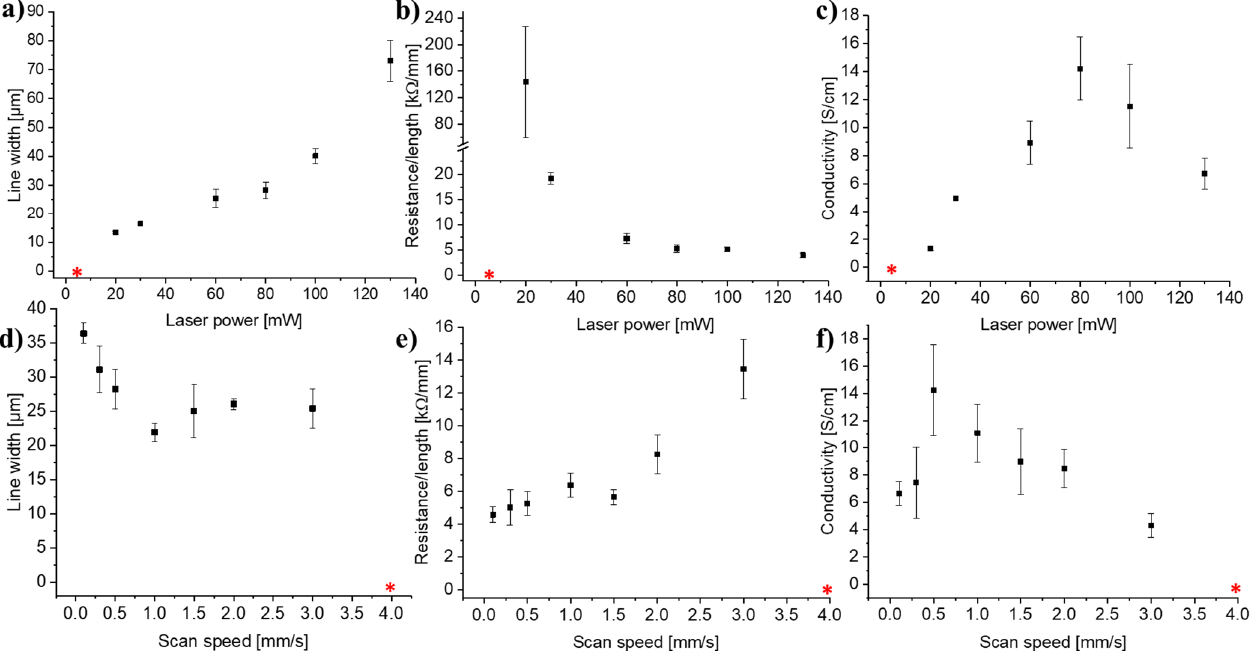
Figure 10. Extracts from the electrical and SEM evaluation of lines written at different laser powers and scan speeds. ( a ) and ( d ) actual widths of carbonized lines, ( b ) and ( e ) line resistances, ( c ) and ( f ) actual conductivities. Laser settings: ( a – c ) 0.5 mm/s scan speed, ( d – f ) 80 mW laser power. The error bars are the standard deviation ( n = 4). The red asterisks indicate that no conductive lines were formed at these settings.